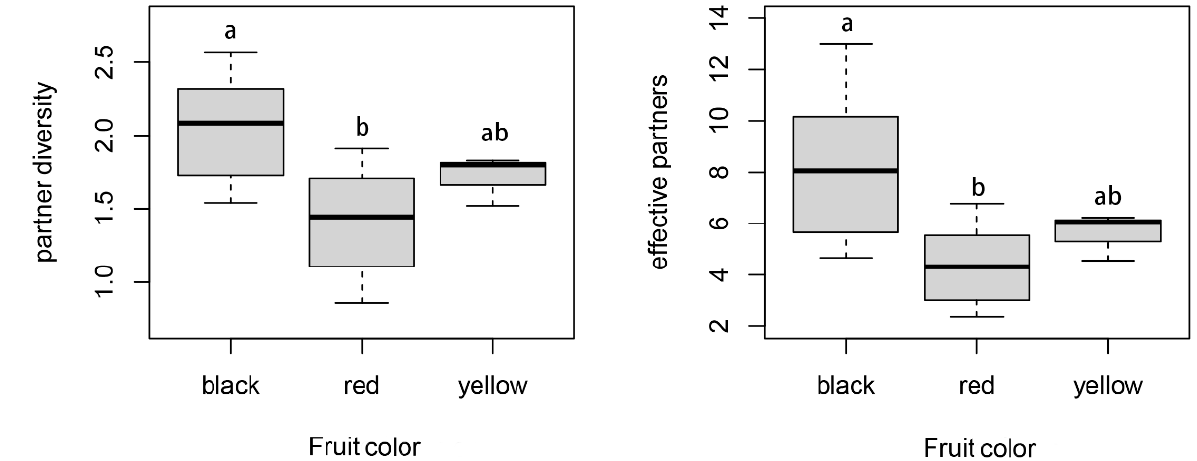
Figure 5. Partner diversity and effective partners of plants with different colors of fruit. 3.4. Important Fruit Plants and Frugivore Birds in the Plant–Frugivore Network We selected six important species of fruit plants and three important species of fru- givore birds using cluster analysis based on species strength, PC1 score, and number of effective partners (Table 1; Figure S6). The six important fruit plants were Cinnamomum camphora (P6), Photinia davidsoniae (P11), Taxus chinensis (P3), Phoebe chekiangensis (P7), Melia azedarach (P20), and Fatsia japonica (P16) (Table 1), contributed 39.12%, 11.91%, 6.12%, 6.80%, 3.75%, and 4.07% of the connections to the interactive network respectively (Table 2), and these important species collectively contributed 71.78% of the connections. All except P20 are evergreen plants with black or red fruit (seed). The three important species of frugivore birds were Pycnonotus sinensis (B12), Cyanopica cyanus (B4), and Turdus mandarinus (B29), which were the most important frugivore birds in the network, they contributed 34.98%, 16.29%, and 16.28% of the connections to the interactive network, respectively (Table 2), and these important species collectively contributed 67.55% of the connections. Three birds are omnivorous generalist birds with medium and large sizes. Table 1. The six important species of fruit plants and three important species of frugivore birds with the highest contributions to the network. Ratio Species Effective Partner Code Species PC1 (%) Strength Partners Diversity Cinnamomum P6 39.12 26.33 13.11 10.16 2.32 camphora Photinia P11 davidsoniae